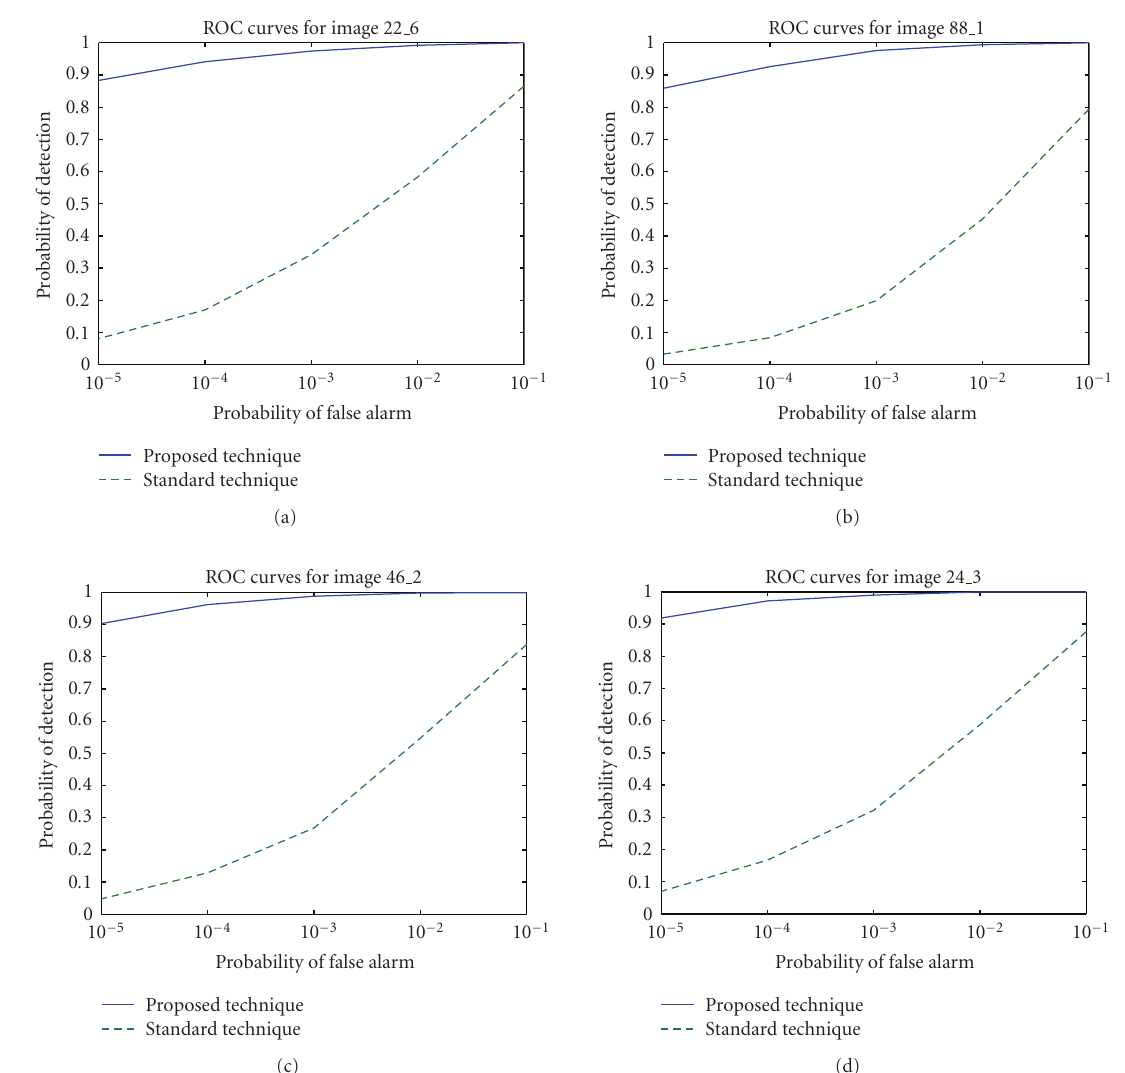
Figure 10: ROC curves of segmented, watermarked images. Watermarking applied in the DFT domain. Strength λ = 0 . 10.